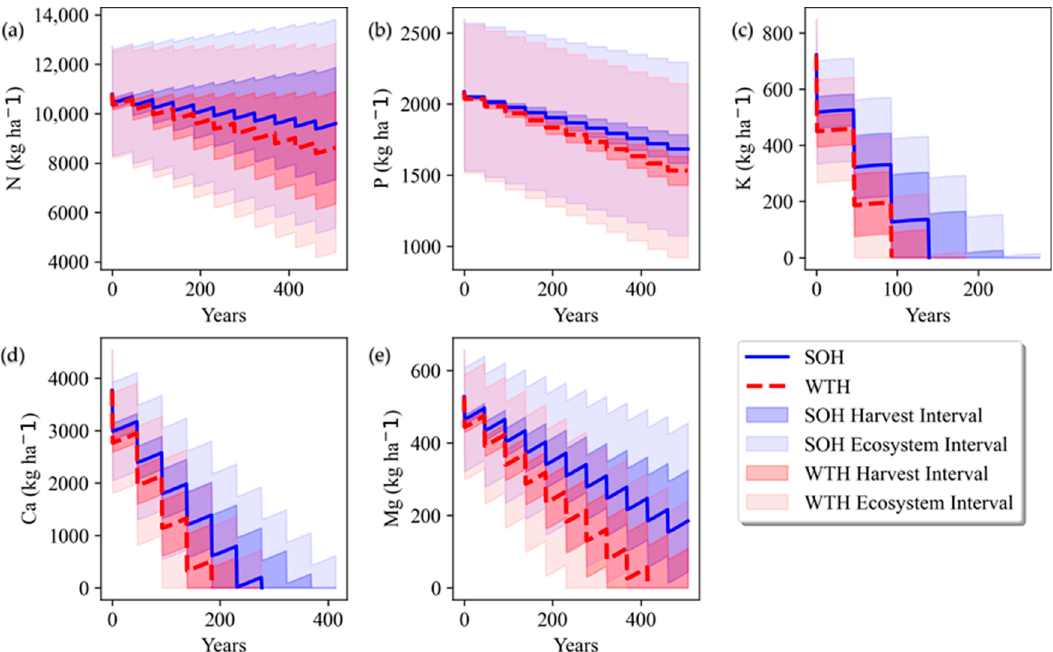
Figure 3. Simulated soil nutrients by scenario for the sampled NRCS pedons with texture-adjusted weathering rates. The N and P showed lower harvest impacts ( a ) N are totals (exchangeable unavailable) and ( b ) P total is unchanged (weathering unavailable). The depletion of K and Ca ( c , d ) is reached by 5 SOHs and 4 WTHs, and the Mg ( e ) is depleted in 6 SOHs and 5 WTHs. The control (CON) shows ( a , d , e ) accumulation in N, Ca, and Mg ( b , c ) gradual losses in P and K. Confidence intervals show large variability ( α = 0.05).